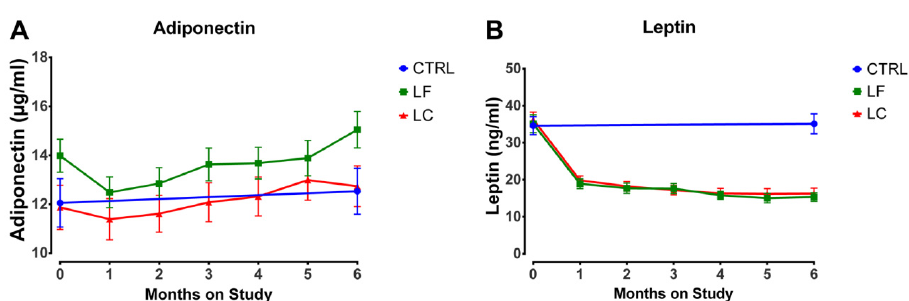
Figure 2. Plasma adipokine concentrations duration weight loss. Groups are non intervention control, CTRL; low fat dietary pattern weight loss intervention arm, LF; and low carbohydrate dietary pattern weight loss intervention arm, LC. Values are means ±